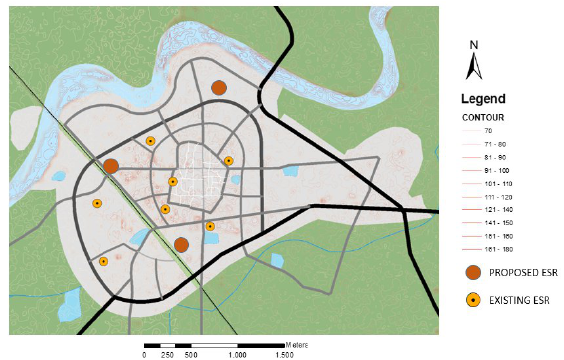
Figure 9. Water supply location